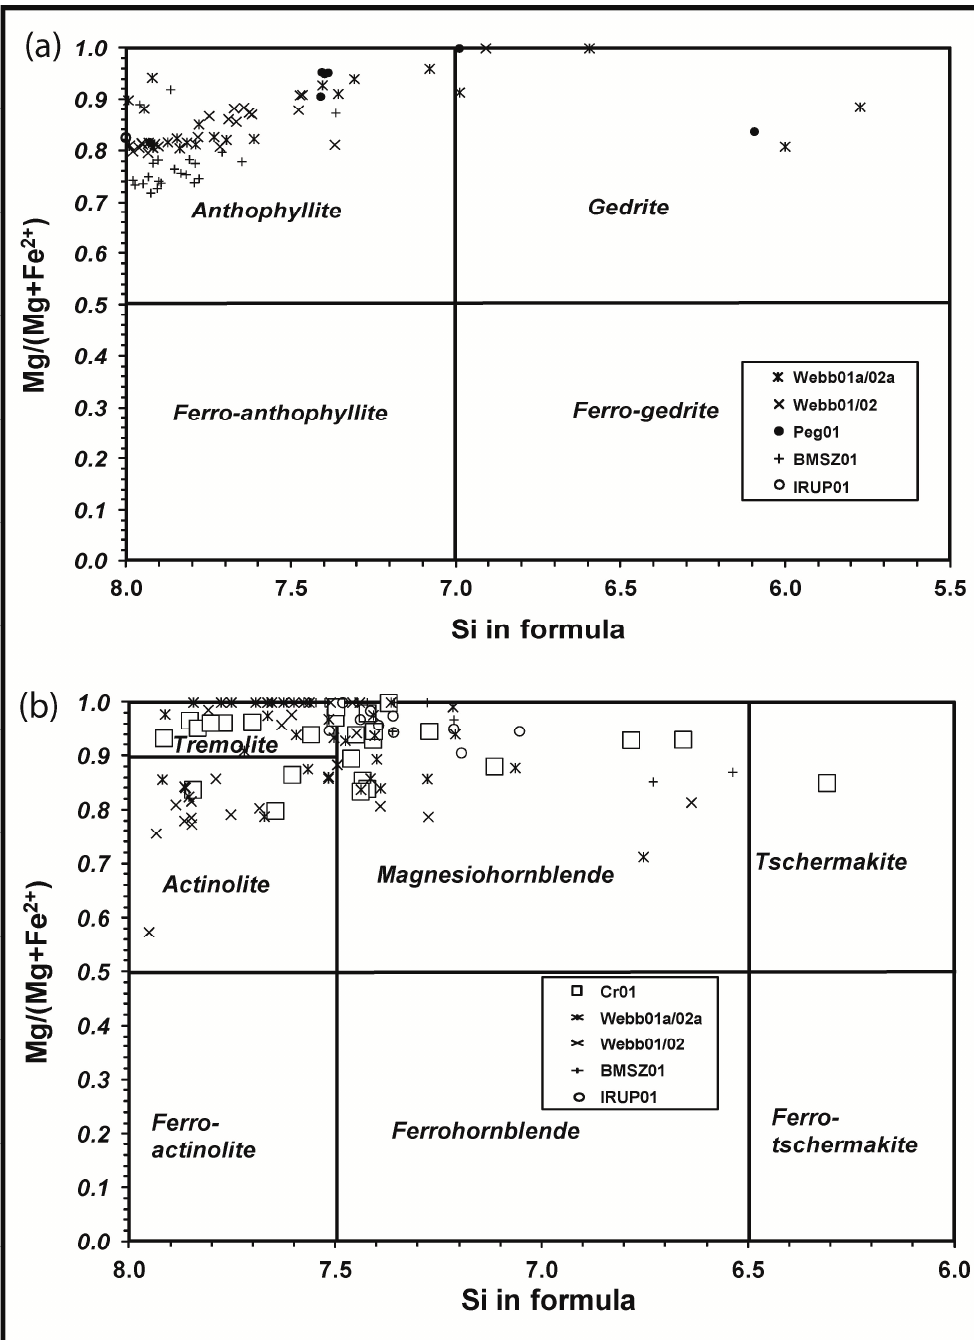
Figure 15. ( a ) Plot of amphibole analyses from MSZ on the Fe-Mg-Mn ( a ), and calcic amphibole ( b ), classification diagrams of Leake et al. (1997) [68]. All Fe-Mg-Mn amphiboles plot in the anthophyllite and gedrite fields ( a ) whereas calcic amphiboles mostly plot in the tremolite, actinolite, and magnesiohornblende fields ( b ).